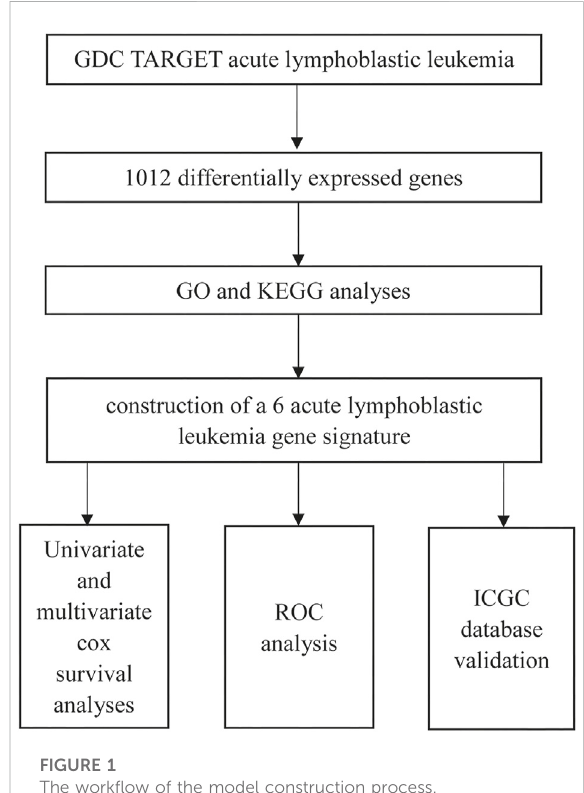
FIGURE 1 The work fl ow of the model construction